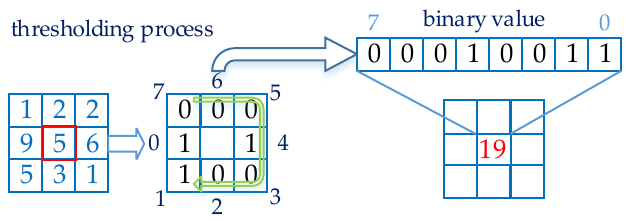
Figure 3. Application of the Local Binary Patterns method.